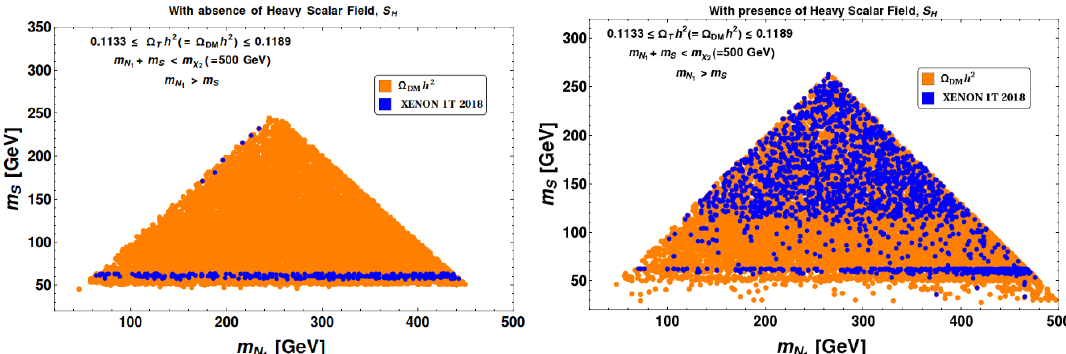
Figure 17 . Allowed region of parameters space in m N m S plane, which satisfy relic density 1 (cid:0) (Orange points) and direct search constraints for both N 1 and S by XENON1T data (blue points) for m N > m S . In left panel, we show the original two component scenario in absence of heavy 1 scalar ( S H ) and in the right panel, we show it in presence of additional heavy scalar S H